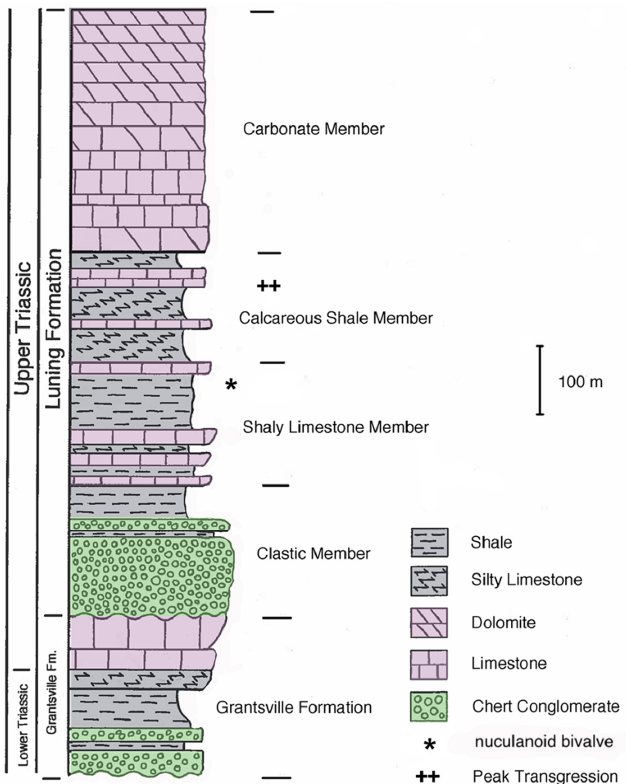
Figure 2. Stratigraphy of the Luning and Grantsville Formations, west–central Nevada. Double plus sign (++) represents the point of maximum transgression during the deposition of the Luning For- mation; asterisk indicates the estimated stratigraphic position of the fossil horizon. Strata in the for- mation deposited above the point of maximum transgression (++) are part of a shoaling upward interval; strata deposited below this point are part of a deepening upward